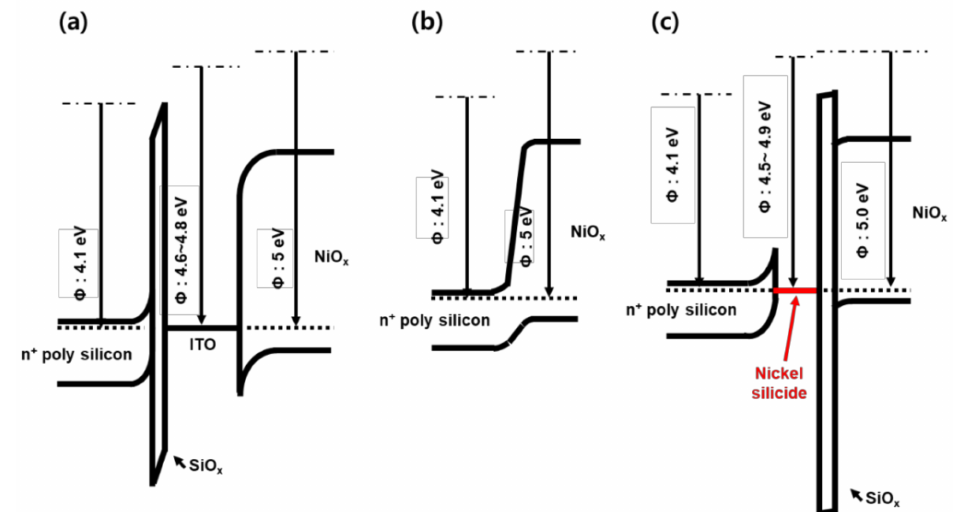
Figure 5. Energy band diagrams of: ( a ) NiOx/ITO/n + poly-Si; ( b ) NiOx/n + poly-Si; ( c ) NiOx/Ni silicide/n +